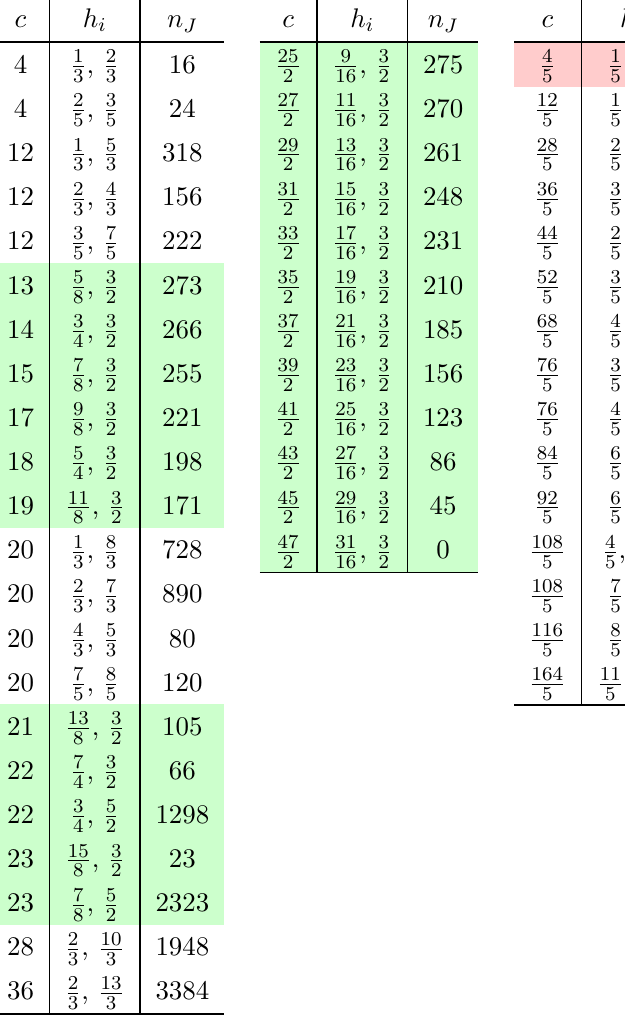
Table 5 . List of all potential ( d, ‘ ) = (3 , 0) theories, not including the infinite series of theories Spin( n ) . Rows colored red denote theories which admit multiple vacuum interpretations. Here 1 we have chosen a single possible interpretation, and n interpretation. Rows colored green (blue) denote cases with a positive (negative) integer Verlinde